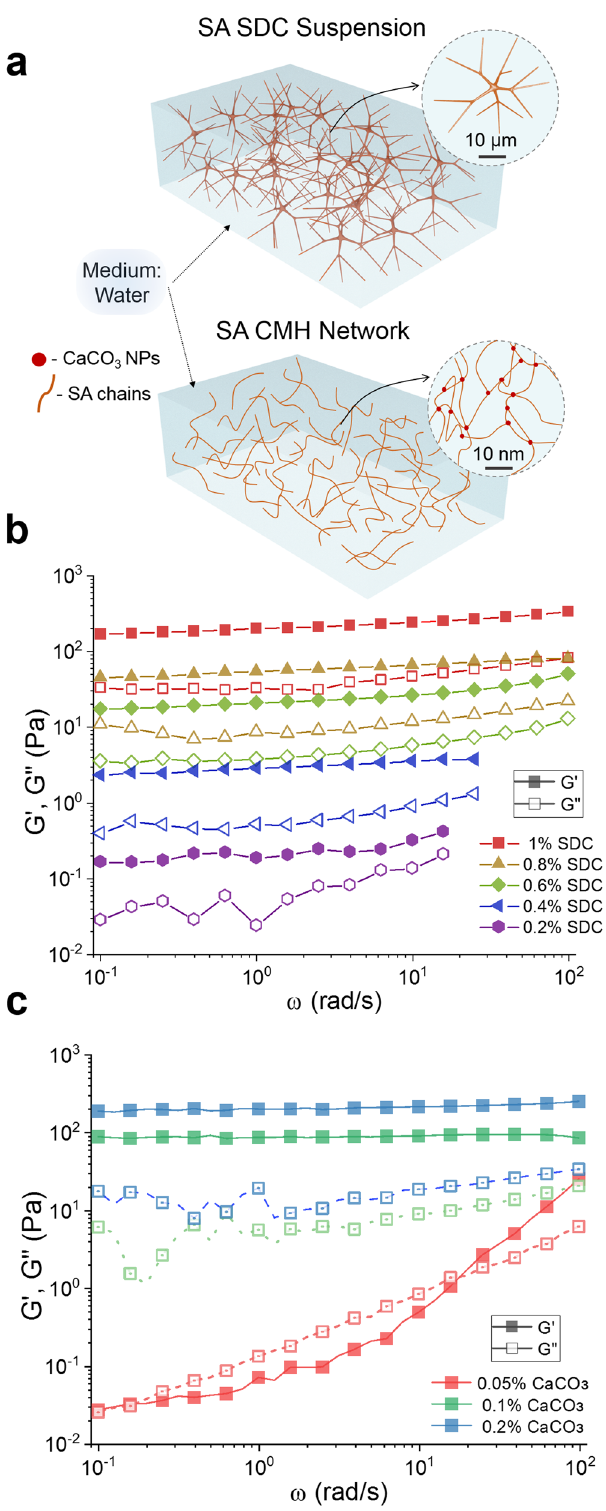
Fig. 2 Linear viscoelasticity and yield stress of SA SDC suspensions and molecular gels. a Scheme comparing the gelation mode of a viscoelastic suspension of SDCs and of a crosslinked SA molecular hydrogel (CMH). Note the different length scales of the networks. b Frequency sweeps indicating the storage modulus ( G ’ , fi lled) and loss modulus ( G ′′ , un fi lled) of SA SDCs in aqueous suspensions. c Frequency sweeps indicating the storage modulus ( G ’ , fi lled) and loss modulus ( G ′′ , un fi lled) of 1.0 wt.% SA CMHs with 0.05 wt.%, 0.1 wt.%, and 0.2 wt.% CaCO 3 nanoparticles and 28.14 mM GDL after equilibration for 2